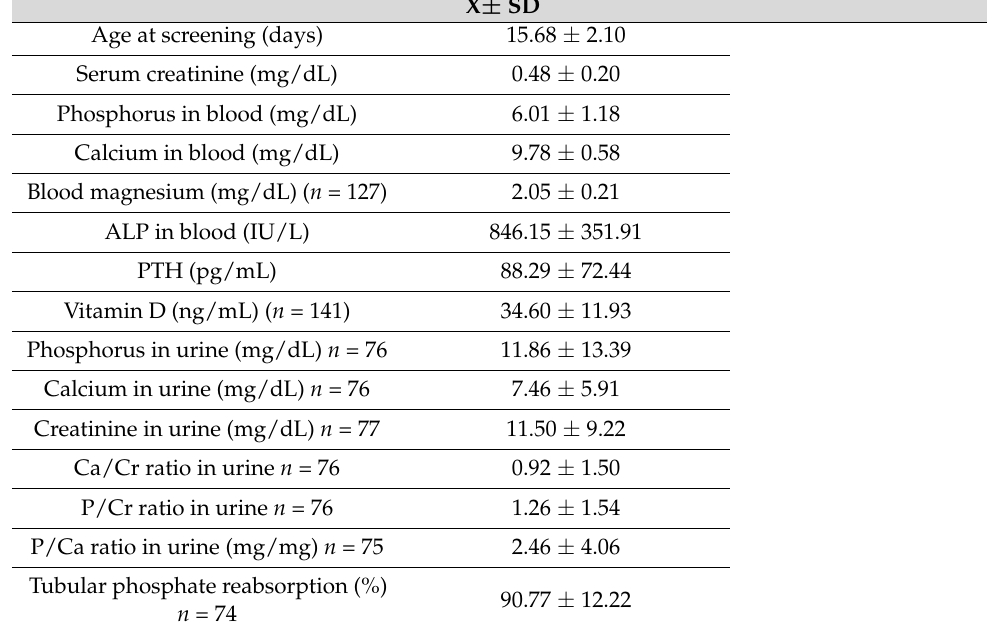
Table 2. Analytical variables of the study cohort.